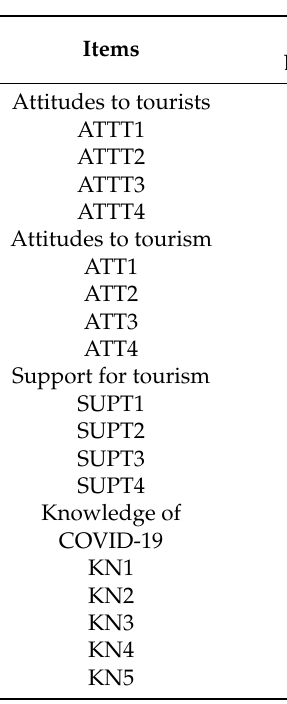
Table 3. Results of measurement